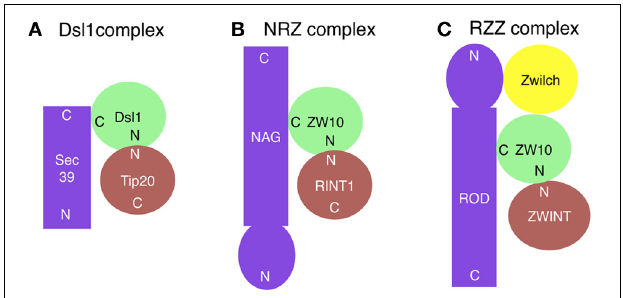
FIGURE 1 | Subunit compositions of the Dsl1 (A), NRZ (B), and RZZ (C) complexes. ZWINT is not included in the RZZ complex, but shown here because it may have a role corresponding to Tip20/RINT1 in the Dsl1/NRZ complexes. The ZW10-binding site on ROD has not been mapped. N and C indicate the N- and C-terminal regions, respectively.